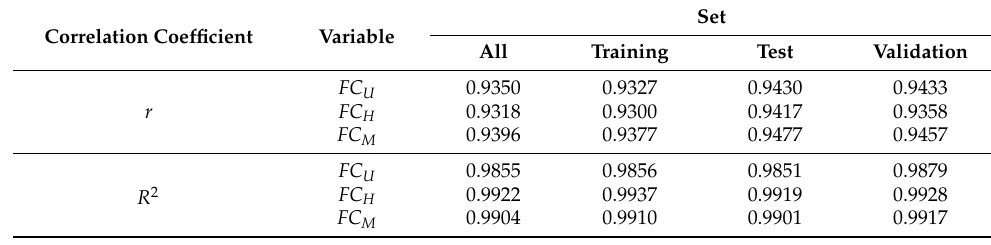
Table 9. Pearson correlation coefficients r and the coefficients of determination R 2 for the MLP 20-10-3 neural network.